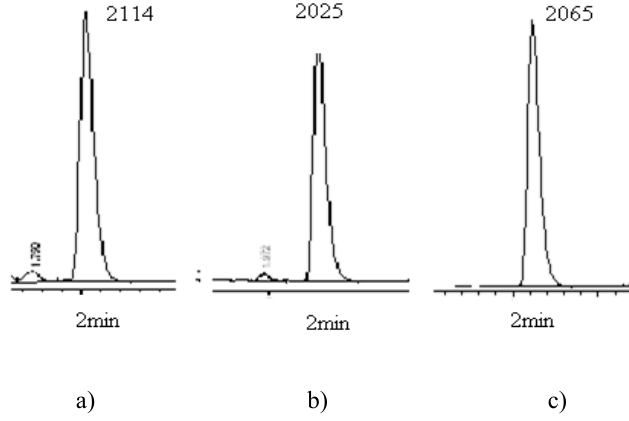
= 20 µgml -1 ), a) Olinth BKC